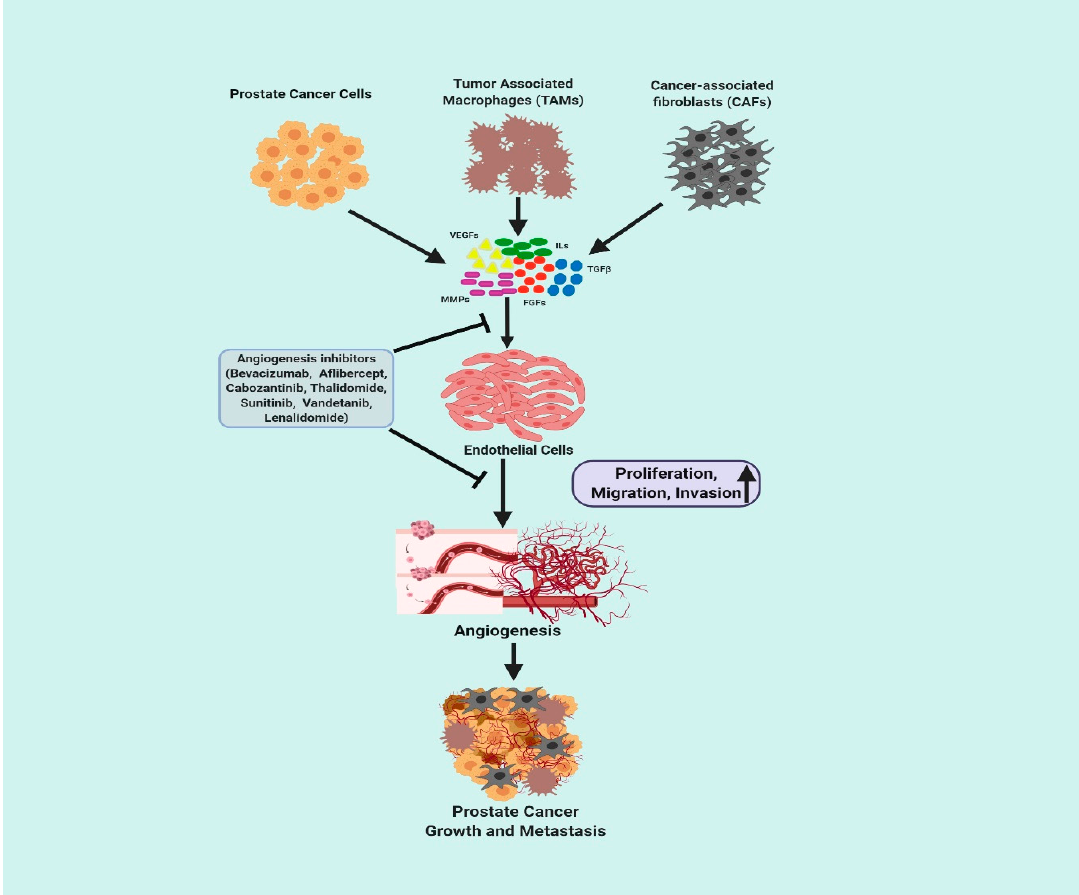
Figure 1. Schematic diagram of the role of angiogenic growth factors in prostate cancer (created with BioRender.com https://biorender.com/). VEGFs = Vascular endothelial growth factors; ILs = Interleukins, MMPs = Matrix metalloproteinases; FGFs = Fibroblast growth factors; TGF β = Transforming growth factor beta .